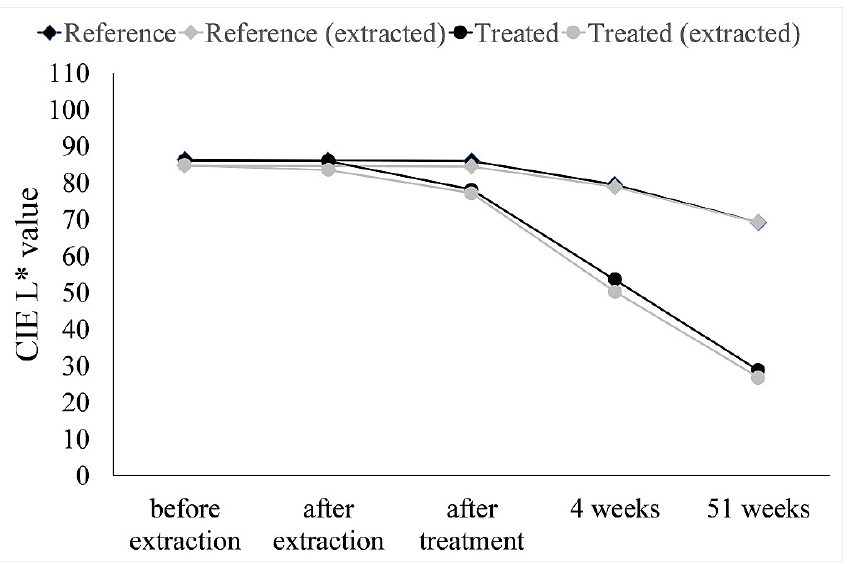
Figure 2. L‐values of the extracted and non‐extracted spruce specimens of sample set 1. Treated = Figure 2. L-values of the extracted and non-extracted spruce specimens of sample set 1. sulfate‐treated iron (II), R = untreated reference. Treated = sulfate-treated iron (II), R = untreated Table 2. Color difference (dE) of the extracted and non‐extracted spruce specimens of sample set 1 at different experimental stages referring to the color before extraction. Treated = sulfate‐treated iron (II), R = untreated reference.